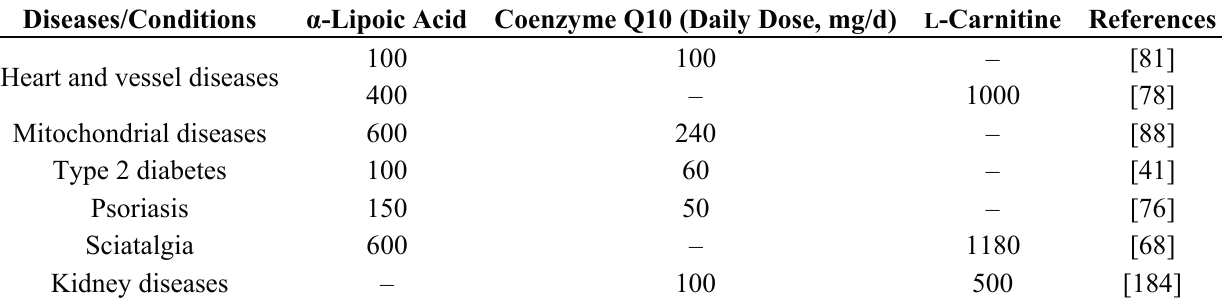
Table 4. Clinical studies utilizing multiple mitochondrial nutrients ( α -lipoic acid and/or coenzyme Q10 and/or L -carnitine) aimed at compensating OS/MDF-related pathogenetic